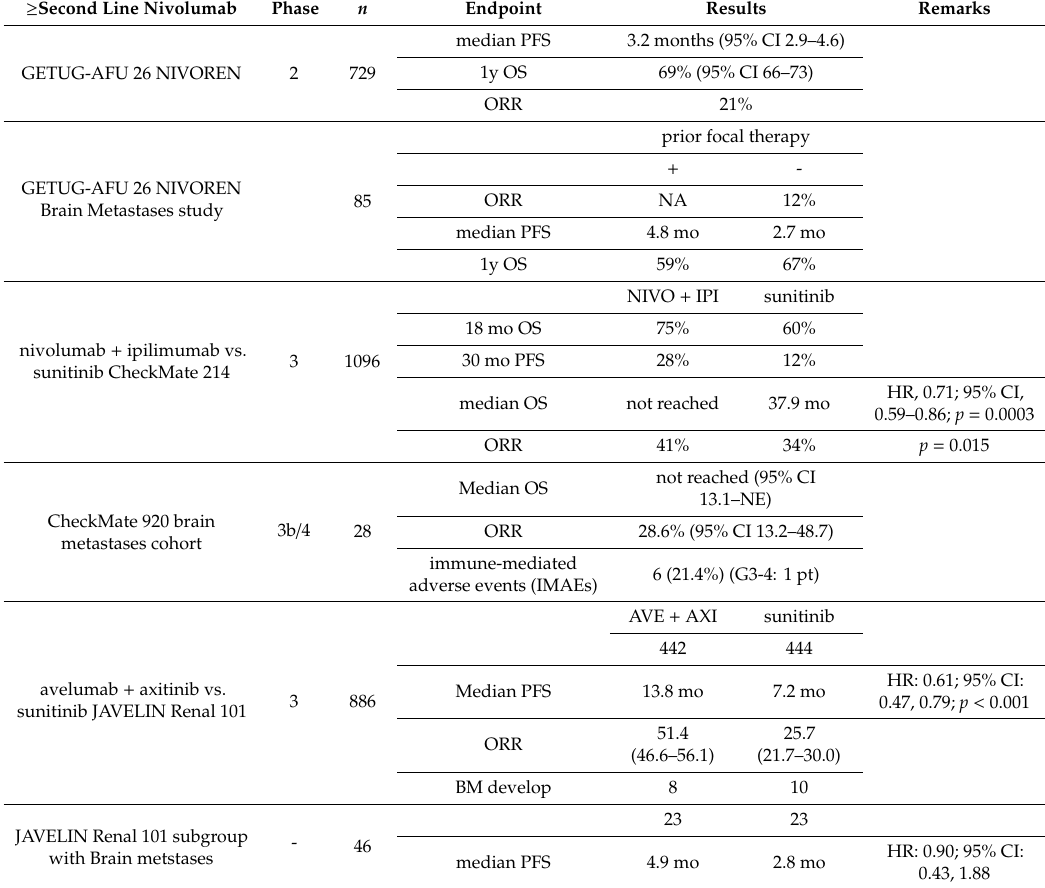
Table 1. The comparison of the results of clinical trials of ICI against RCC between whole group and brain metastases